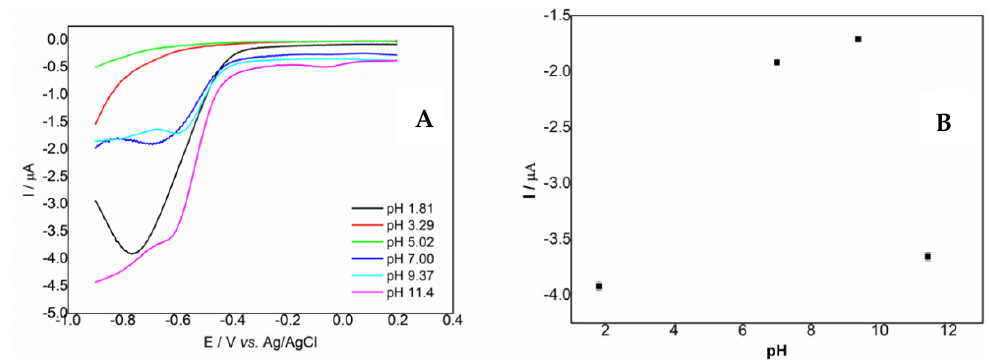
Figure 3. ( A ) Cyclic voltammetry profiles of MWCNT /IL/MO electrodes in presence of 5 mmol L − 1 sulfite in 0.04 mol L − 1 BRB, pH 1.81–11.4, in Ar. ( B ) Maximum cathodic current (Ip) vs. pH obtained from Figure 3A. The error bars represent the standard deviation of three independent measurements.